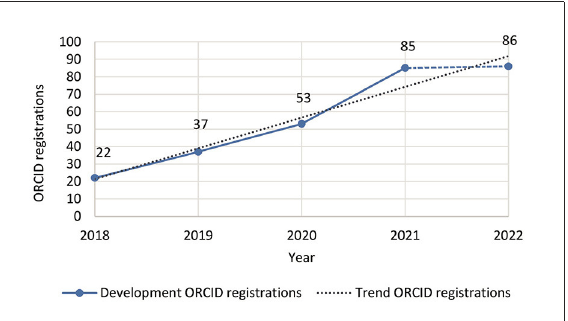
FIGURE3 Development of ORCID registrations for TIB employees (source: ORCID Member Portal, March 2022).